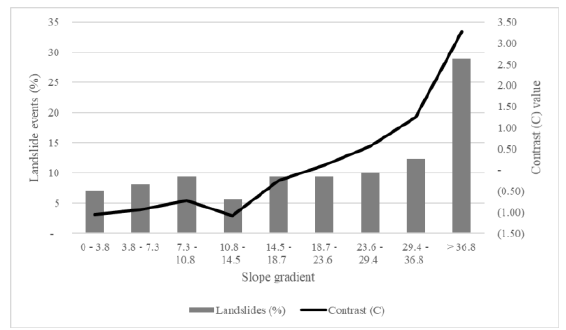
Figure 3 Distribution of landslide events (left vertical axis) and contrast C value (right vertical axis) with slope gradient (°).